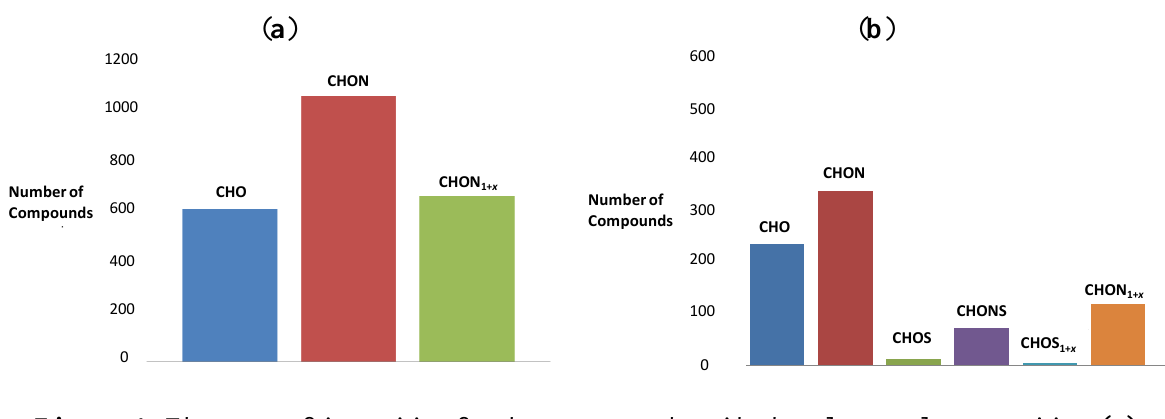
Figure 4. The sum of intensities for the compounds with the elemental composition ( a ) CHO, CHON and CHON for the reaction of serine with sucrose and ( b ) the elemental 1+ x composition CHO, CHON, CHOS, CHONS, CHOS and CHON for the reaction of 1+ x 1+ x cysteine with sucrose analyzed by negative ion mode FT